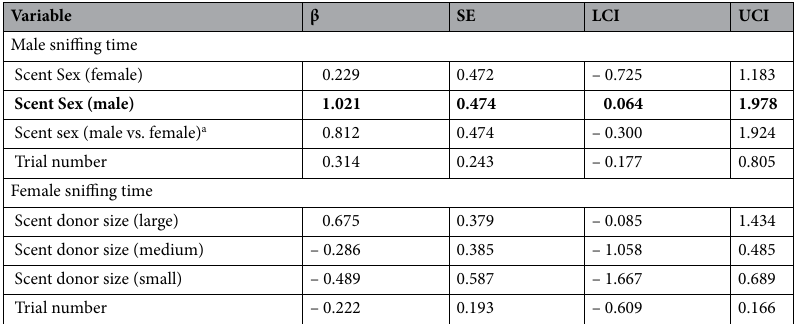
each other for resources, which can lead to high levels of aggression 24 . However, males are generally more able to